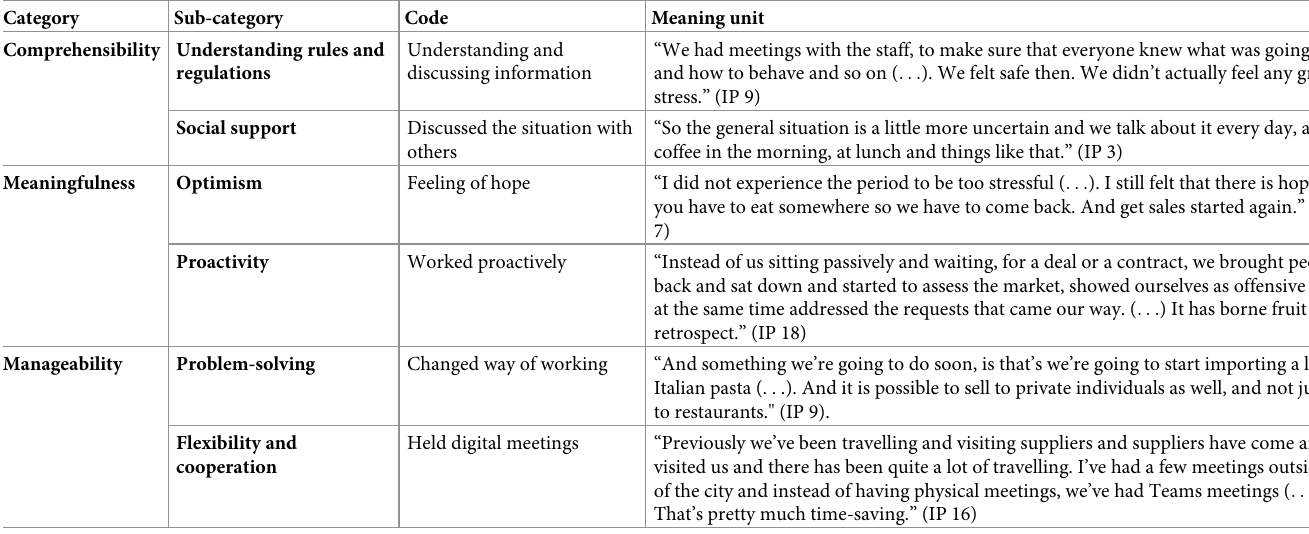
Table 2. Coding framework based on the sense of coherence